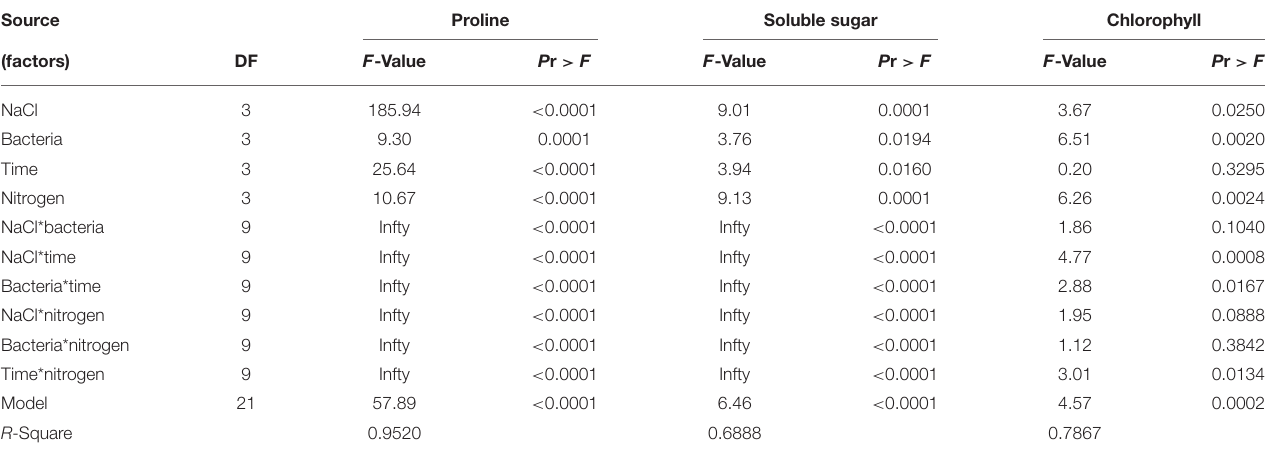
TABLE 5 | Variance analyses for the models of proline, soluble sugar, and chlorophyll content, for each experimental factor and among